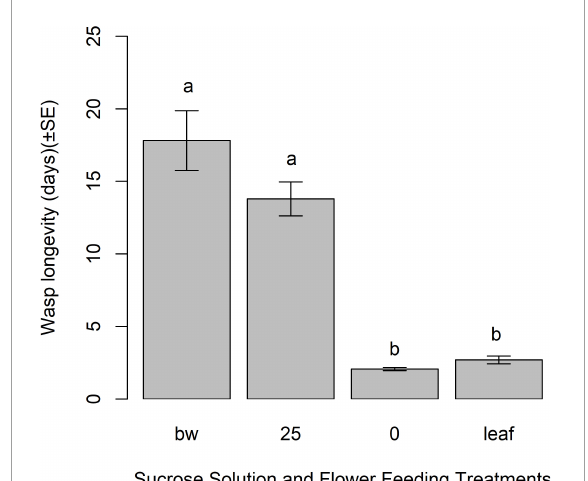
FIGURE5 Mean longevity (d) of unmated Apanteles polychrosidis with buckwheat nectar or sucrose feeding. Each wasp ( n = 13–41) was provided with a feeding treatment of either 25% (v/v) (25) sucrose in deionized water, a deionized water control (0), 5–20 buckwheat blossoms, or a buckwheat leaf control. Results were compared using a generalized linear model with a negative binomial error distribution. Differences between treatments, determined by compact letter display (cld) of multiple pairwise comparisons, shown with lower case letters ( p < 0.05).